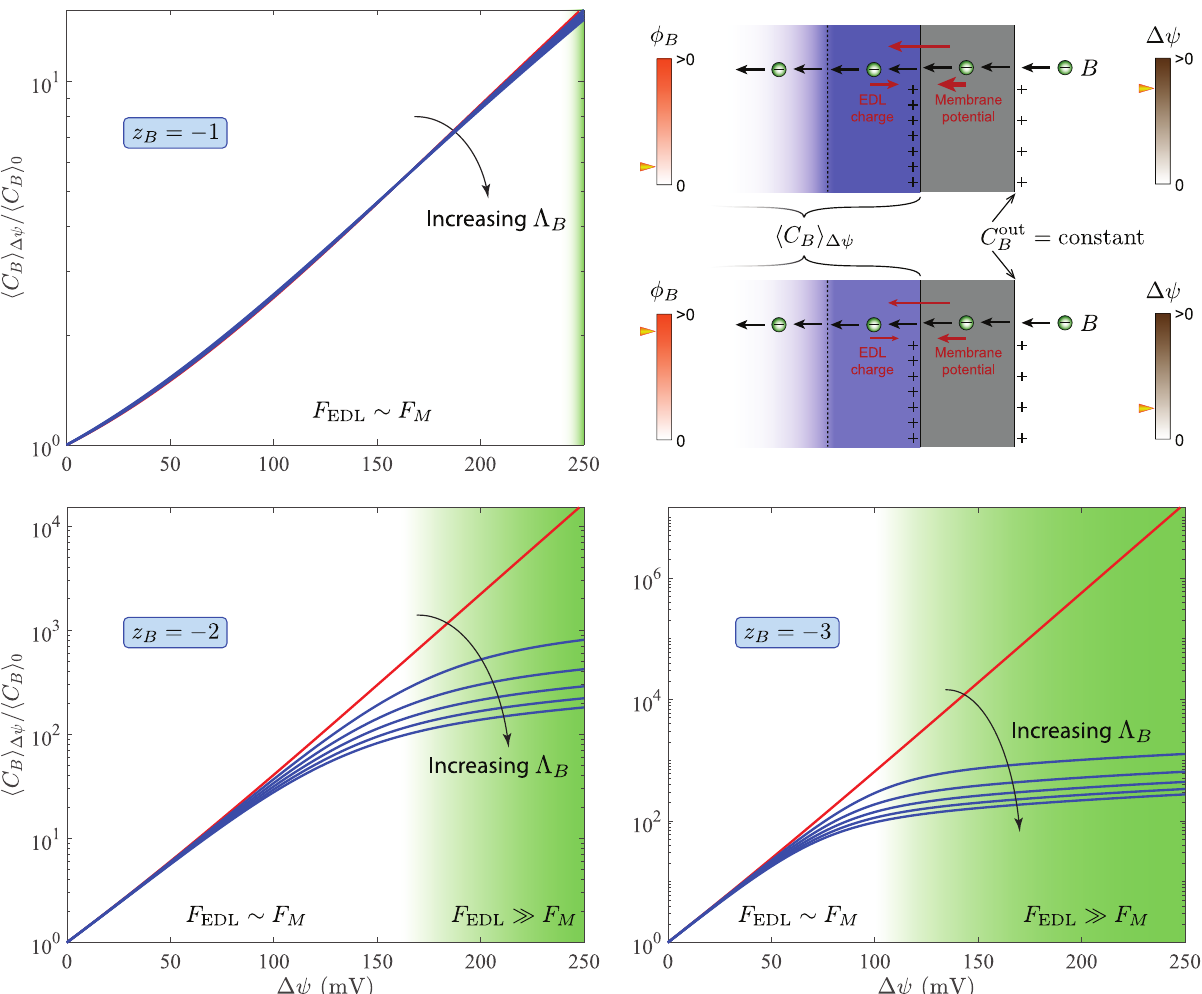
Fig 5. Enhancement of reactive-species concentrations by the membrane potential. The membrane potential Δ ψ and reaction efficiency ϕ “Methods: Concentration Heterogeneity and Reaction Efficiency”) for a reactive species B are evaluated at C salt = 0.1 M, σ r = 0.02, and R c = 10 − 8 m along a steady-state solution branch parametrized with the surface-charge density σ . The ratio h C enhancement, is determined at fixed C out represent the nonreactive limit, where